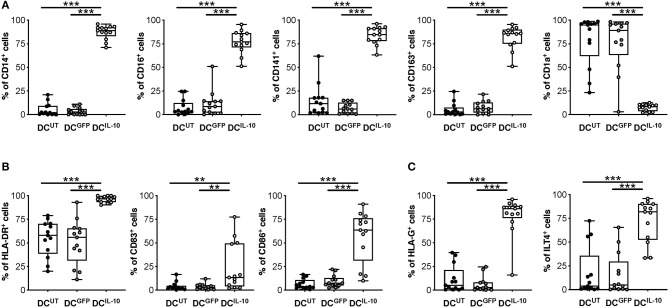
DCIL−10 are myeloid mature cells and express markers associated with tolerogenic DC-10. DCIL−10 were differentiated as described in method section. At the end of differentiation, the expression of the indicated markers was evaluated by flow cytometry. (A) Markers associated with DC-10 differentiation (CD14, CD16, CD163, CD141 CD1a); (B) HLA class II (HLA-DR), and co-stimulatory (CD83 and CD86) molecules; (C) Tolerogenic molecules (HLA-G and ILT4). Each dot represents a single donor (n = 13), lines indicate median, while whiskers are minimum and maximum levels. **P ≤ 0.01, ***P ≤ 0.001 (Wilcoxon matched pairs test, two-tailed).